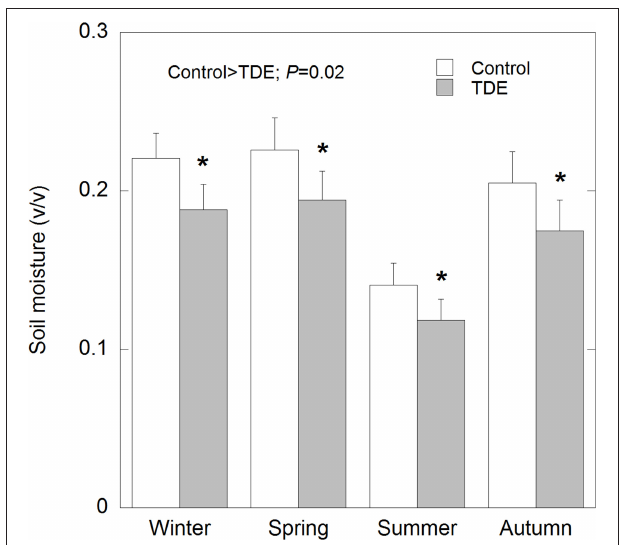
FIGURE 1 | Soil moisture in Control and TDE plots in the four annual seasons. Error bars correspond to the standard error of the mean ( n = 4). * P < 0.05.